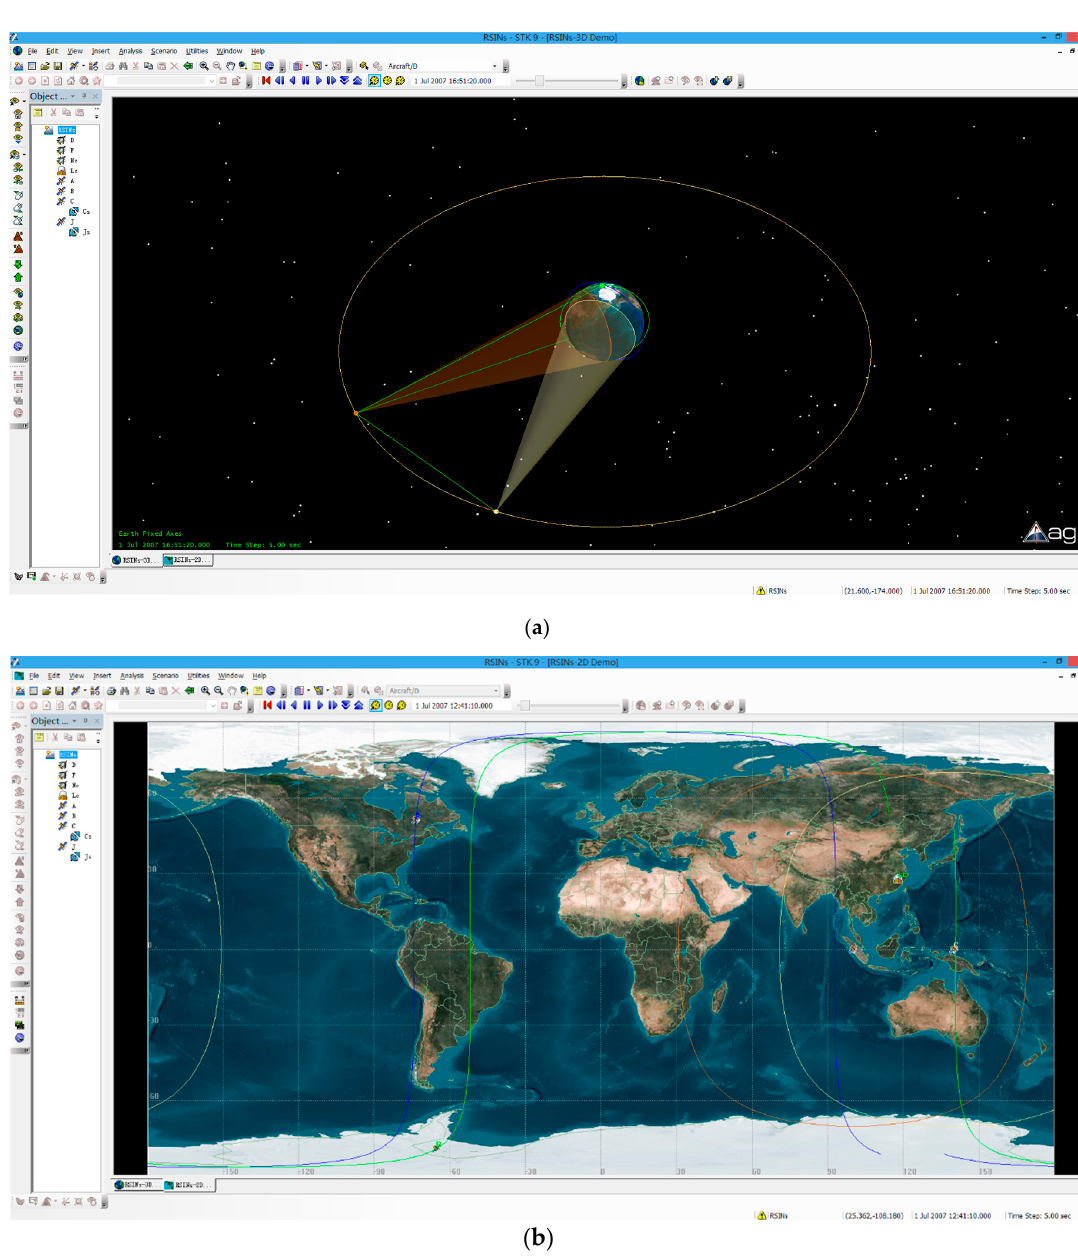
Figure 11. The R-SIN demo model supporting anti-missile tasks: ( a ) the three-dimensional (3D) demo model; ( b ) the two-dimensional (2D) demo model.